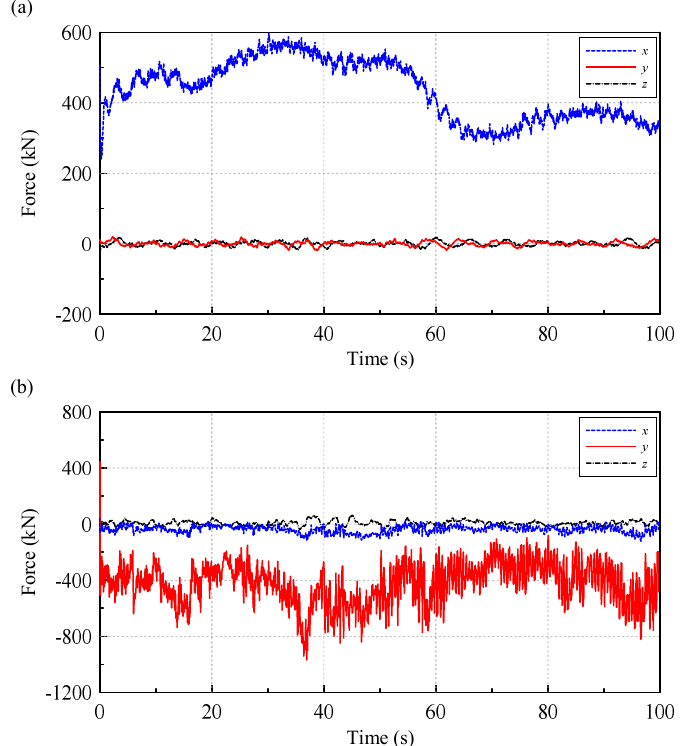
Figure 16. The forces on RNA: ( a ) normal wind condition; ( b ) extreme wind condition.